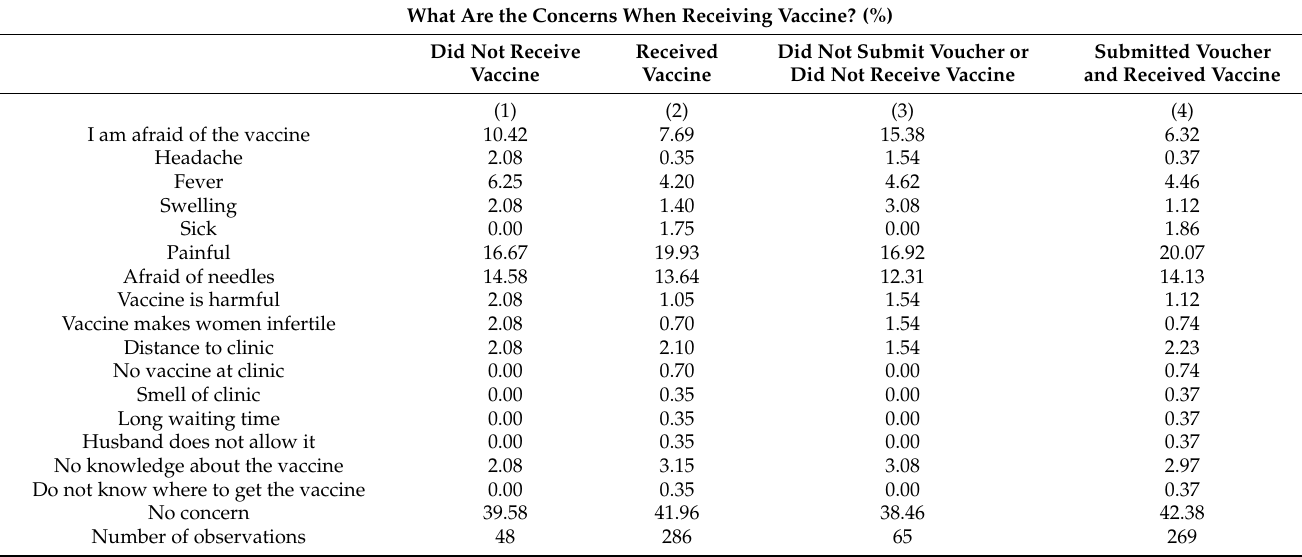
Table 9. Concerns about receiving vaccines among treated